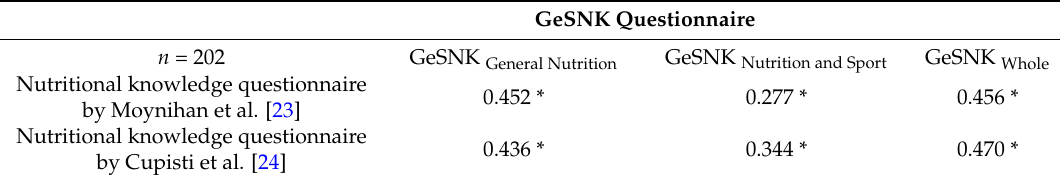
Table 2. Correlations of the GeSNK questionnaire with two questionnaires of nutritional knowledge (Moynihan et al. 2007; Cupisti et al. 2002). GeSNK Questionnaire GeSNK General Nutrition GeSNK Nutrition and Sport GeSNK Whole Nutritional knowledge questionnaire